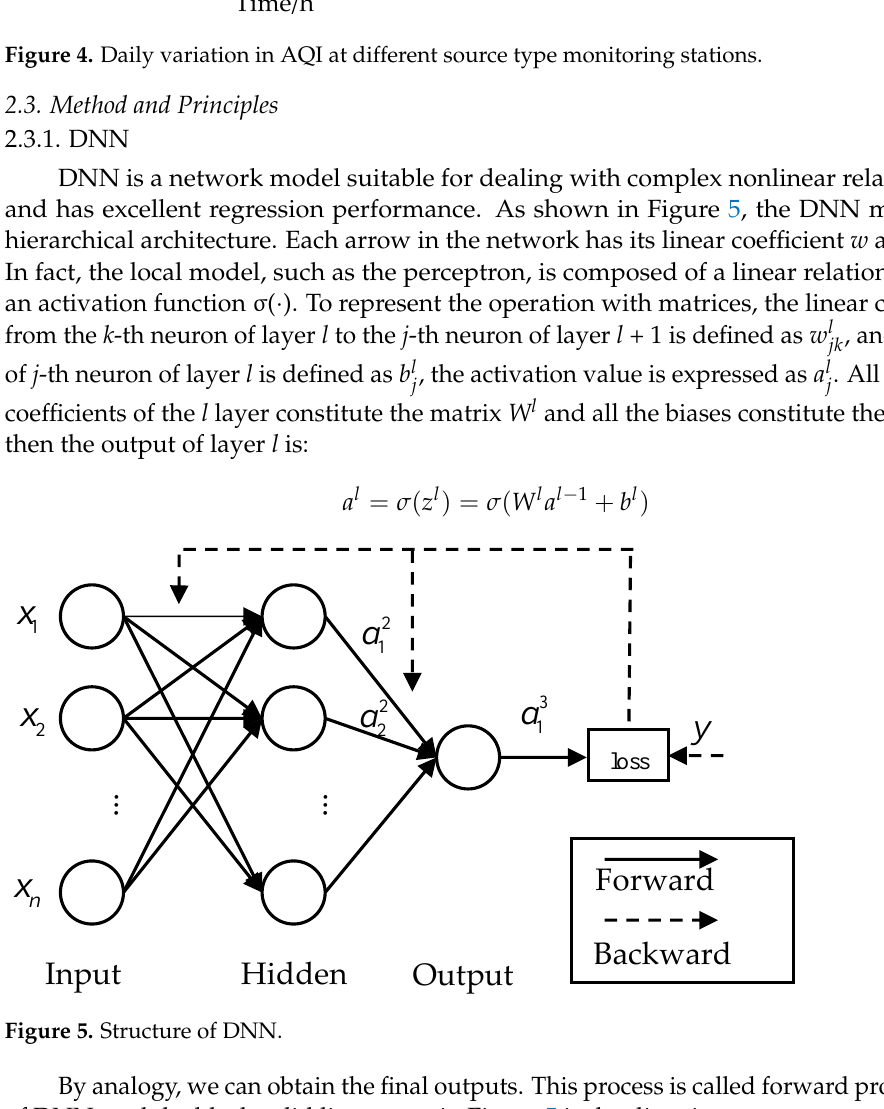
Figure 4. Daily variation in AQI at different source type monitoring stations.